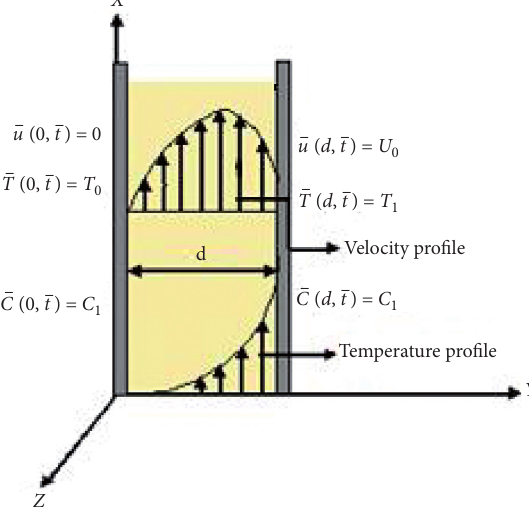
Figure 1: Flow geometry.